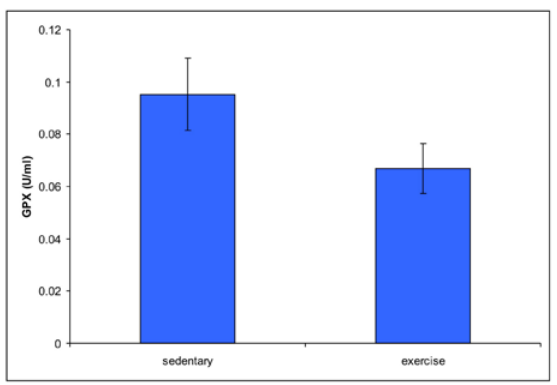
Figure 2. The effects of five minutes treadmill exercise on GPX specific activity from the rat serum. The values are mean ± SEM (n=7 animals per